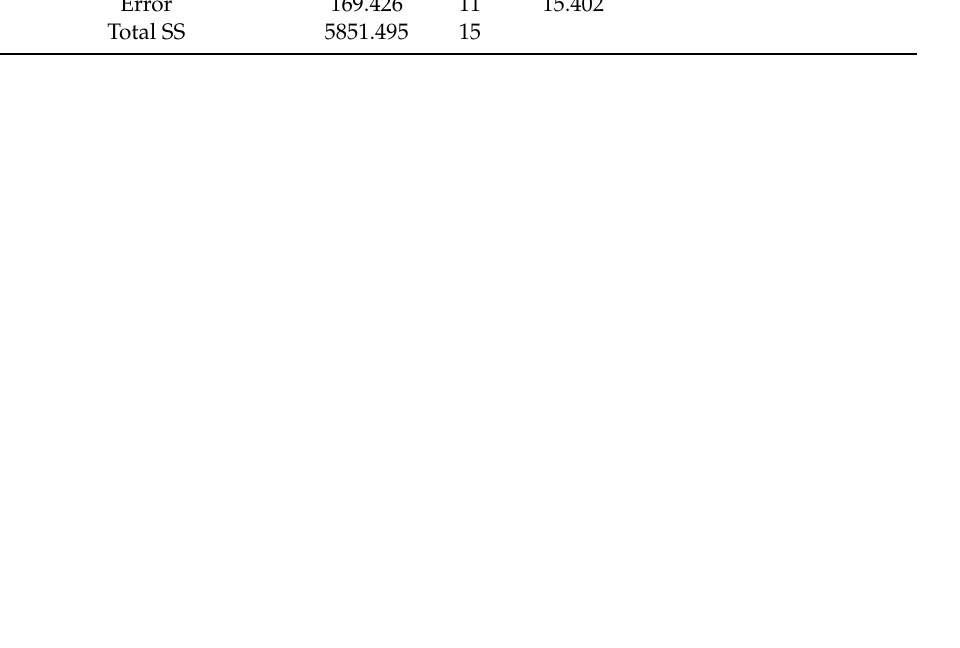
Figure 2. Pareto maps of the standardized effects (2 4 experimental configuration).